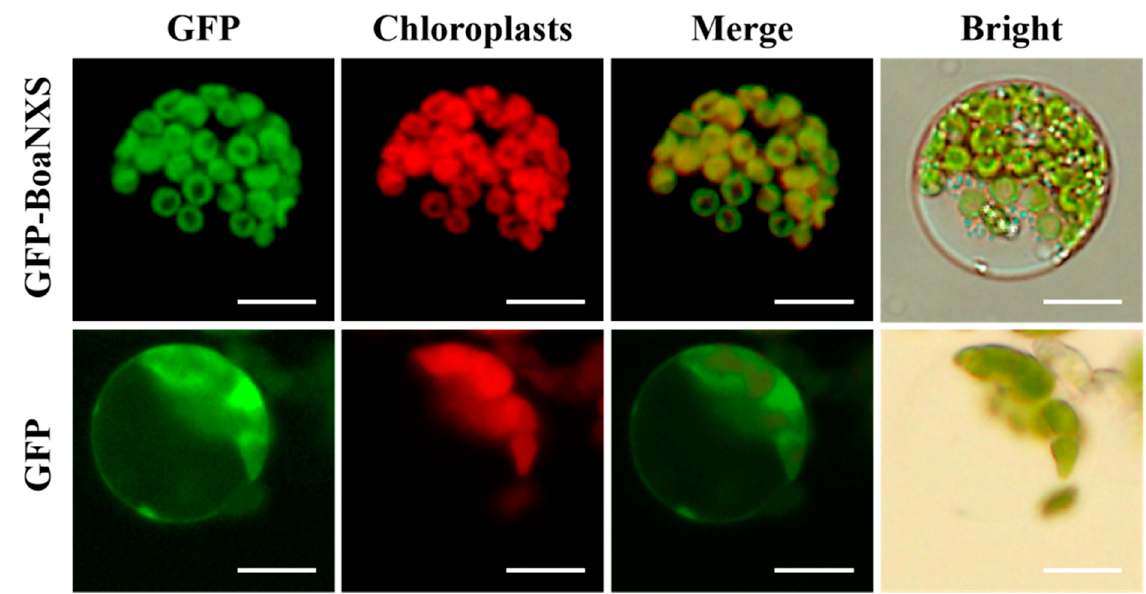
Figure 3. Subcellular localization of BoaNXS in Chinese kale. Free green fluorescing protein served as a control. The upper column represents transient expression of GFP-BoaNXS fusion protein in Chinese kale protoplasts, and the lower column